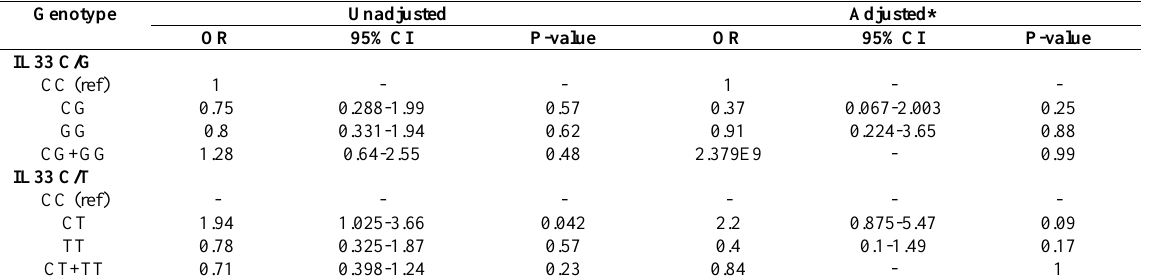
Table 4 . Association of rs1157505C/G and rs11792633C/T variations and Tuberculosis after adjustment for binary logistic regression.